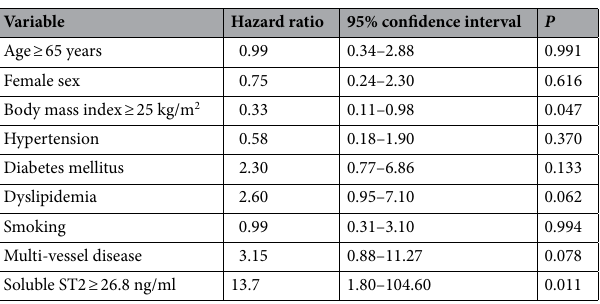
Table 2. Independent association between soluble ST2 and clinical